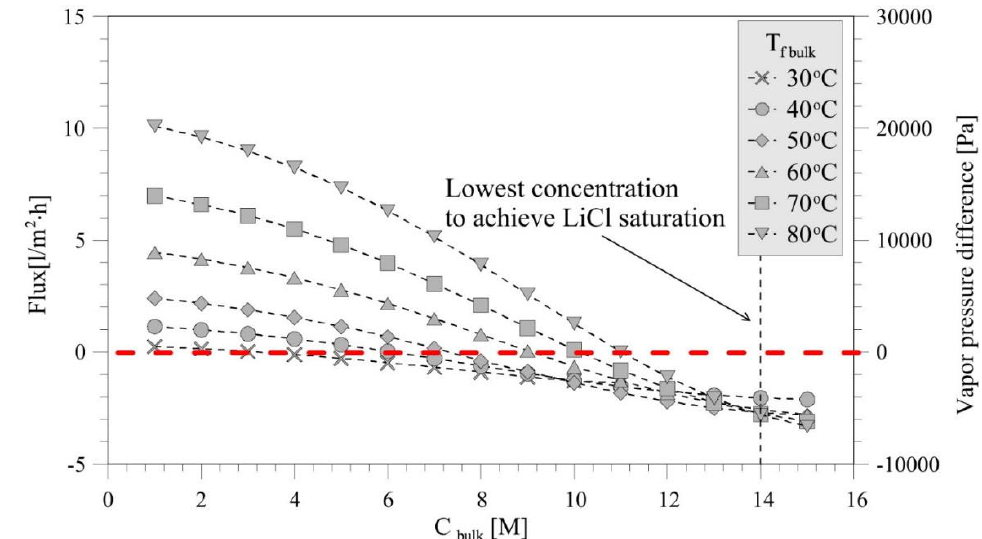
Figure 4. Theoretical flux as function of solution concentration at various feed temperatures for LiCl solution. The vertical dashed line shows the minimum solution concentration required to achieve the crystals from solution. Reproduced with permission from [27]. Copyright Elsevier, 2016.